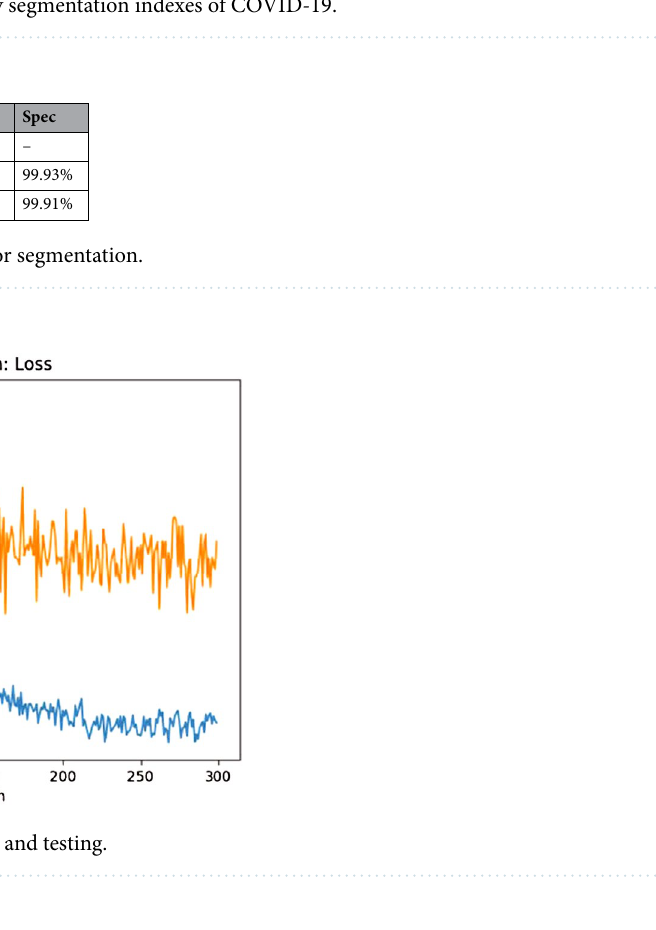
Table 2. Comparison of pulmonary segmentation indexes of COVID-19.